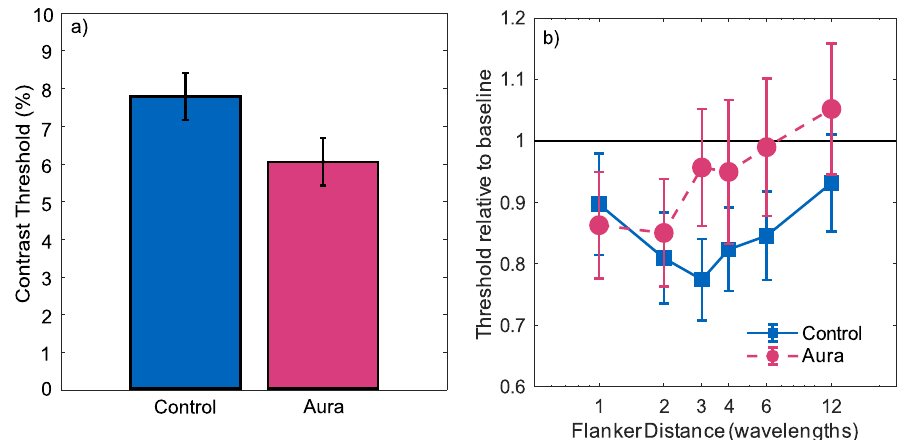
Figure 3. ( a ) Contrast detection thresholds (75% correct) for aura and control groups for Gabor targets in the absence of flankers; ( b ) contrast detection thresholds (75% correct) for stimuli with flankers present. Thresholds are plotted relative to the condition’s baseline (marked by the horizontal black line). Normalisation was undertaken independently for the control and migraine groups. Error bars indicate ± 1 standard